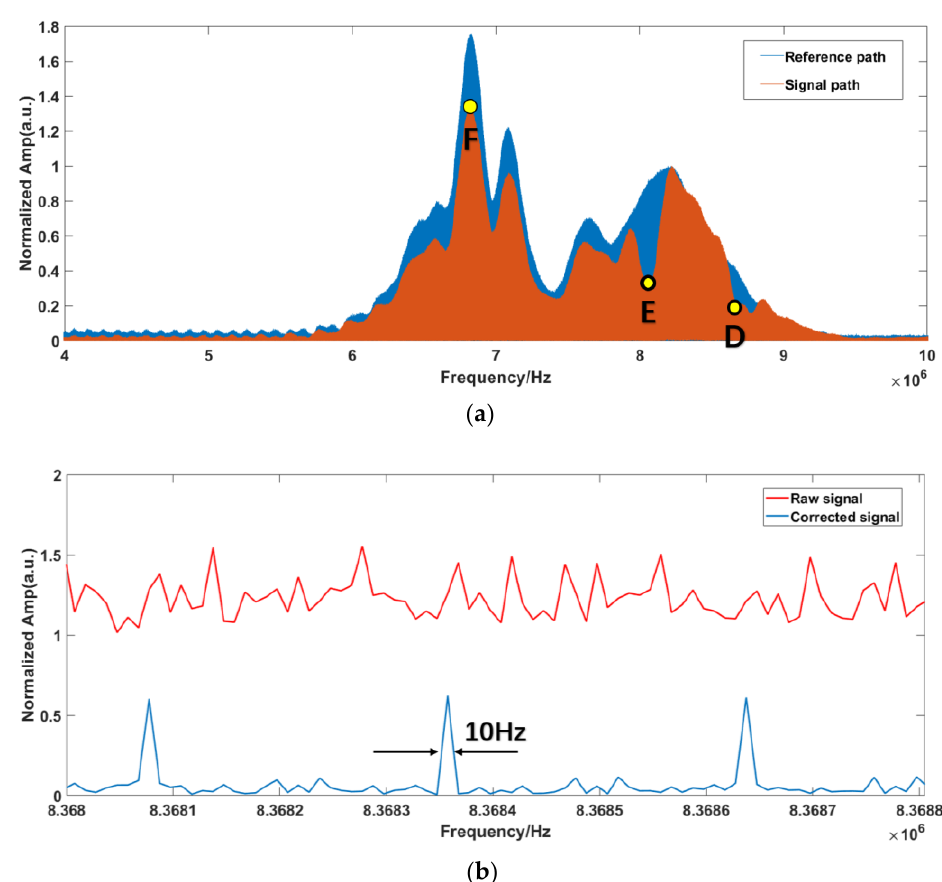
Figure 14. ( a ) Normalized spectrum of the experiment signal. ( b ) Magnified view of the components.